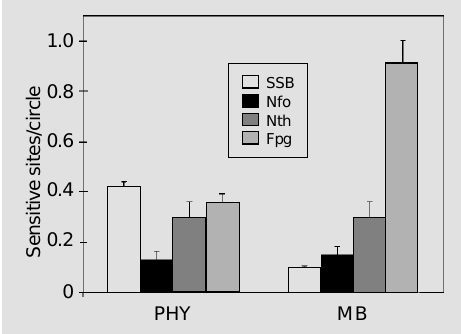
Figure 1 - Formation of single strand breaks (SSB) or enzyme- sensitive sites (ESS) in DNA treated with phycocyanin (PHY) or methylene blue (MB) plus vis- ible light. YEplac181 plasmid DNA was either treated with PHY (500 µg/ml plus visible light: 2 min exposure (25 kJ/m 2 )) or MB (1 µg/ml plus visible light: 12.5-s exposure (2.5 kJ/m 2 )). Treated or untreated DNA was incubated with 10 ng of the puri- fied E. coli endonucleases: Fpg, Nth or Nfo. The average number of nicks per molecule was deter- mined using 0.8% agarose gel electrophoresis as described in Material and Methods. SSB were induced in DNA treated with MB and PHY plus visible light without incubation in the presence of repair endonu- cleases. SSB in DNA treated with PHY or MB plus visible light were subtracted from ESS. In all figures, the results obtained cor- respond to three independent